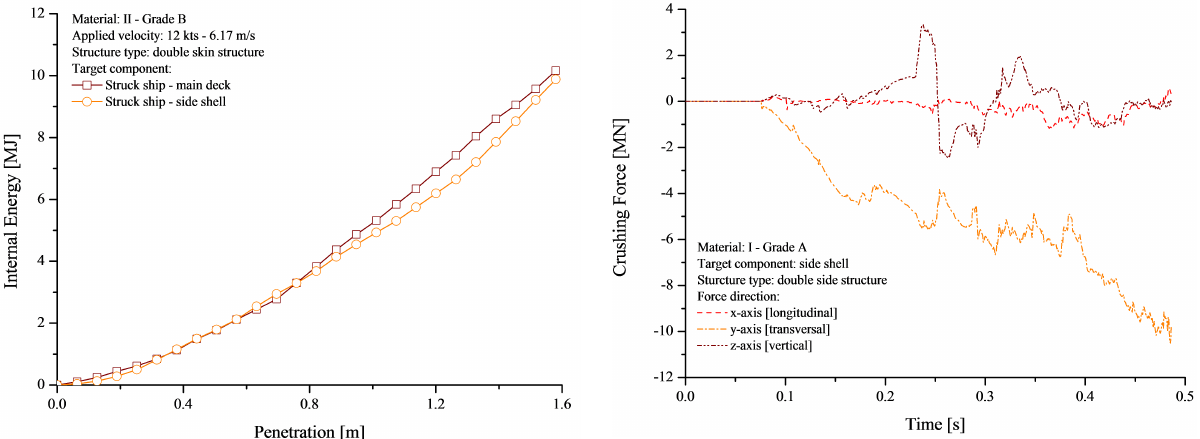
Figure 5: Verification of energy characteristic by the crushing force: double skin